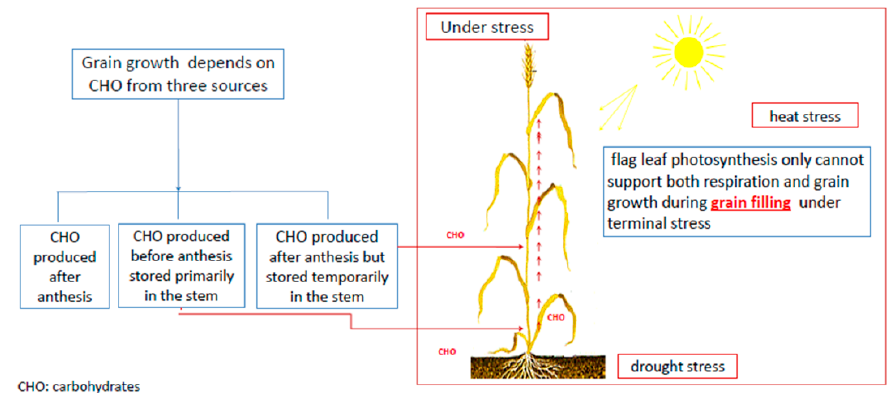
Figure 5. The three souses of carbohydrates that are transferred into grains during grain filling under drought and heat stresses.